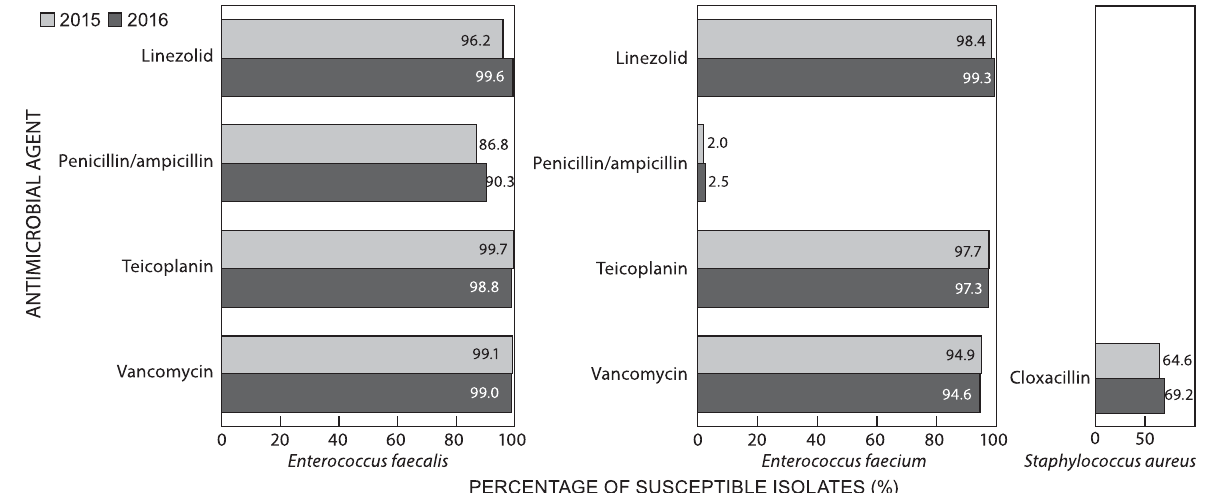
Figure 6: Percentage of susceptible Enterococcus faecalis , Enterococcus faecium and Staphylococcus aureus isolates, 2015 to